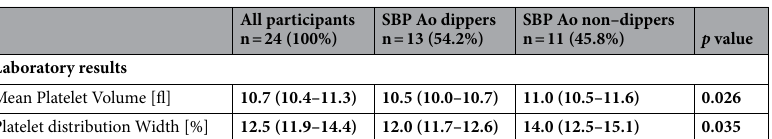
All participants n = 24